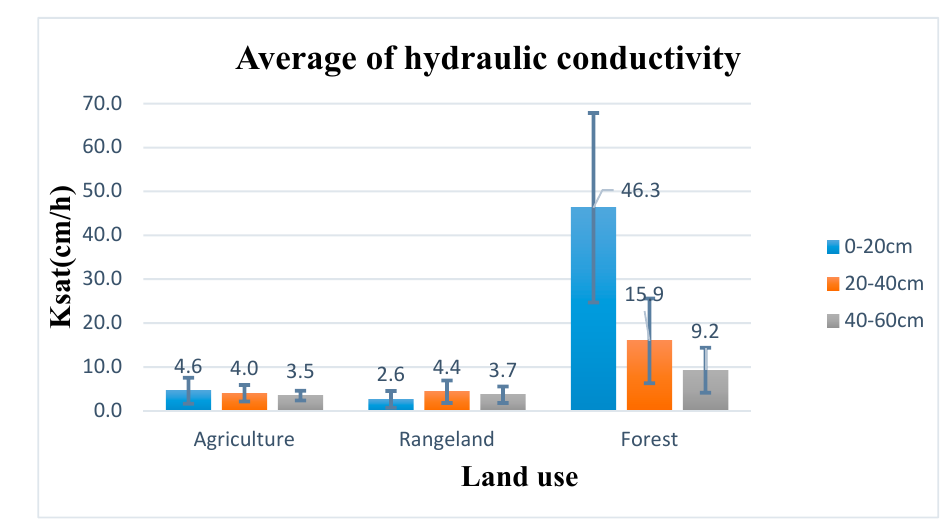
Figure 7. Comparison of hydraulic conductivity of the land uses at di ff erent depths of the catchment.